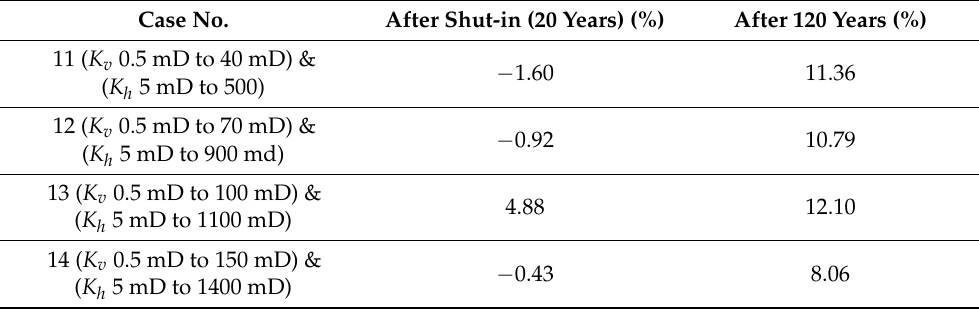
Table 4. Data of increase/decrease of CO 2 dissolution in brine for different ranges.